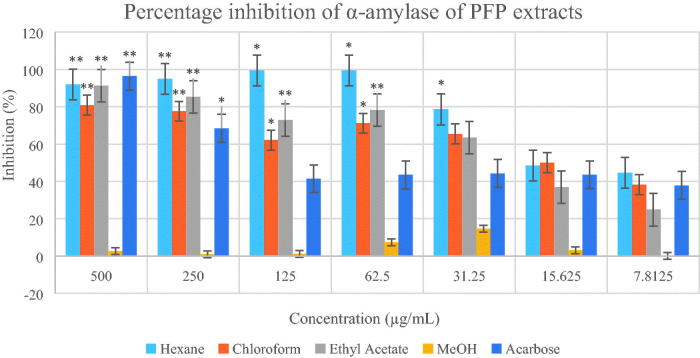
Percentage inhibition of α-amylase by different extracts of Paederia foetida twig from Pahang, Malaysia. The different extracts were compared with acarbose and p < 0.05 (p = 0.0001). *indicates significance at the 0.05 level, **indicates significance at the 0.01 level.